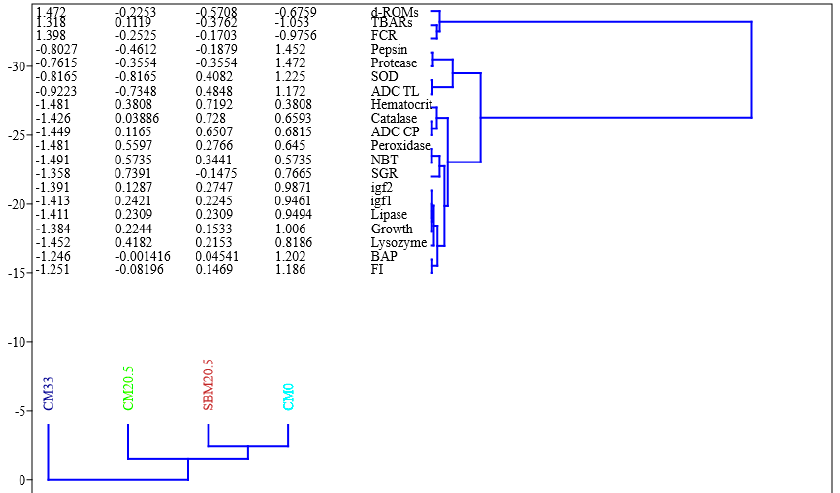
Figure 7. Dendrogram derived from UPMGA analysis of responses of growth, feed utilization indices, immunity markers, stress biomarkers, relative gene expressions, digestibility coefficients, and enzyme activity of red seabream using a corre- lation matrix model, where fours diet treatments formulated by replacing fish meal with camelina meal at 0% for reference diet (CM0), 20.5 g/kg with soybean mean (SBM20.5), 20.5 g/kg with camelina meal (CM20.5) and 33 g/kg camelina meal (CM33).